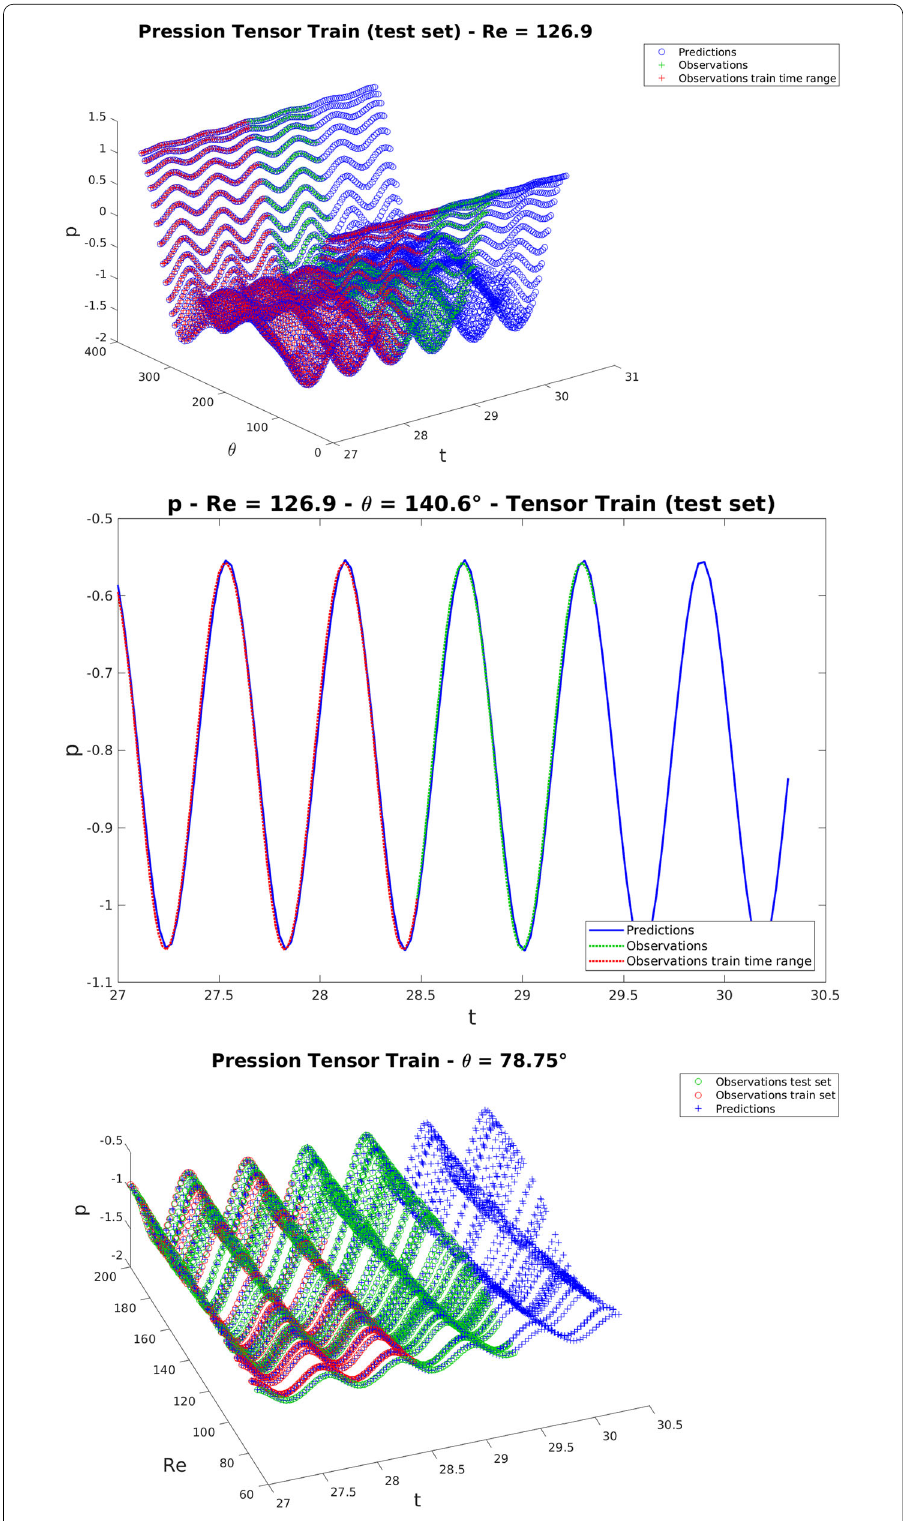
Fig. 2 Low Reynolds numbers. Observations and predictions with respect to time for fixed values of the other parameters. The predictions are obtained using tensor formats combined with constrained changes of